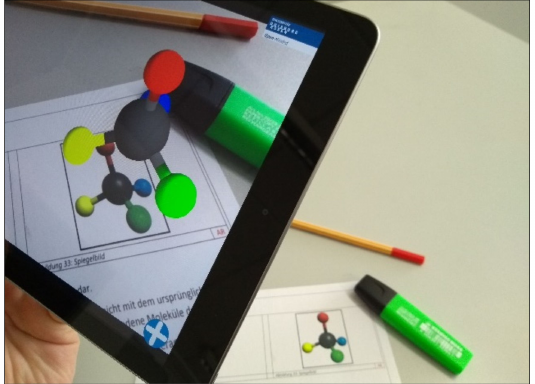
Figure 3. Example of the App Augmented Reality Chemistry (ARC) in use (rotateable 3D